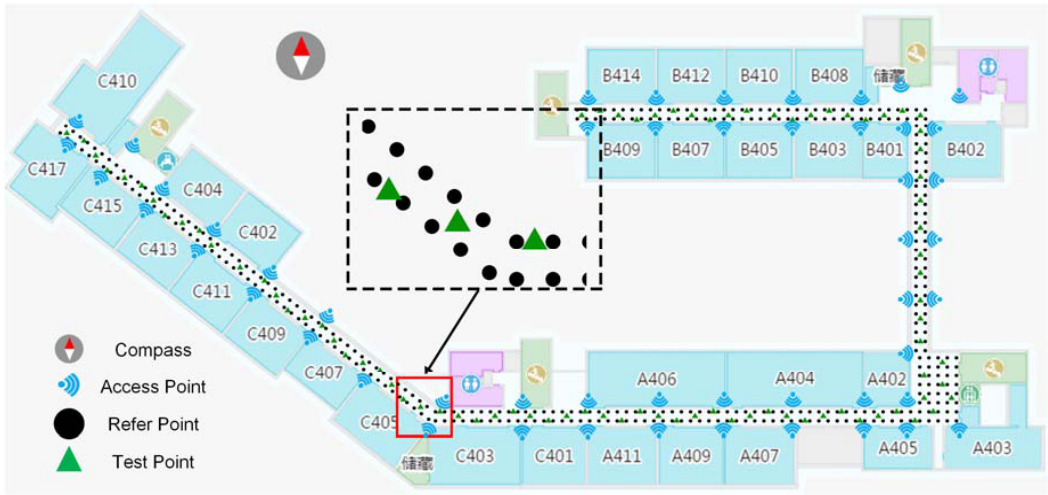
Figure 4. The layout of experimental testbed, the solid dot is refer point, the solid triangle is test point, and the signal mark refers to Wi ‐ Fi access point .